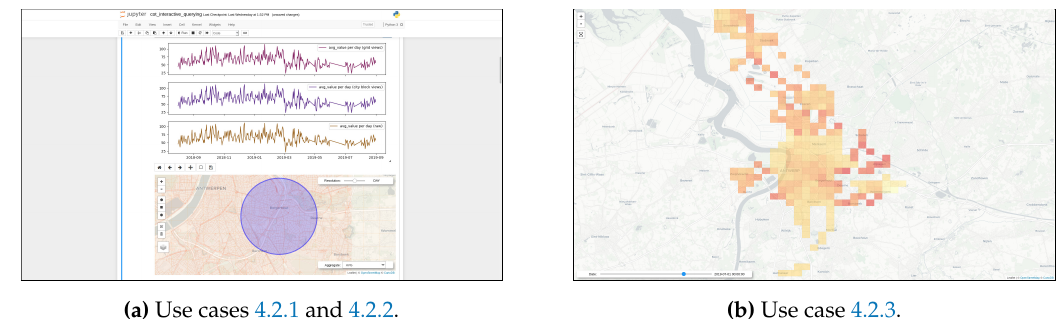
Figure 11. Screen captures of the Jupyter notebooks implementing the target use cases defined in Section